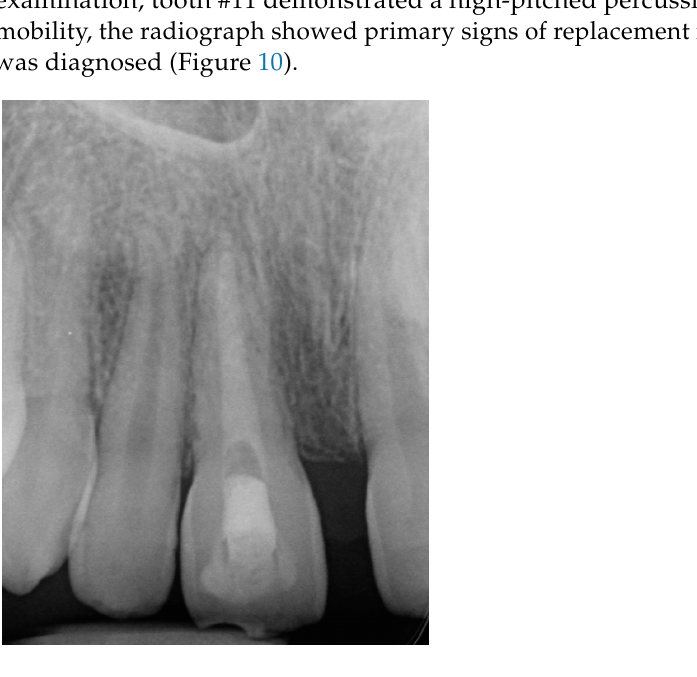
Figure 10. Case 2, two months post-injury. Two weeks after the trauma, root canal treatment was performed, and at the two-month post-injury examination, ankylosis was already diagnosed.